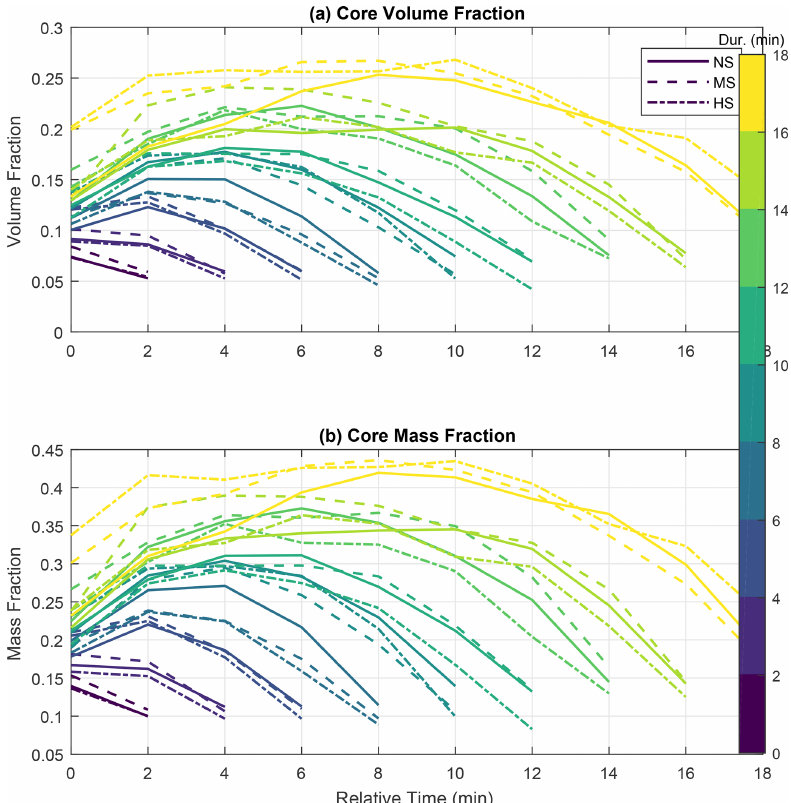
Figure 12. Cloud core volume and mass fraction as a function of cloud life cycle and total duration. The fractions are obtained by the ratio of the total core volume or mass to the total cloud volume or mass. The total duration is given by the number of time steps representative of each tracked cloud. Clouds only present in two time steps are assumed to have a 2min duration time, three time steps equating to a 4min duration, and so on. The volume and mass fraction standard deviations are relatively similar for the time steps of clouds sharing the same duration. For the volume fraction, the standard deviations reach up to approximately 0.15. For mass fractions, they have values of up to 0.22